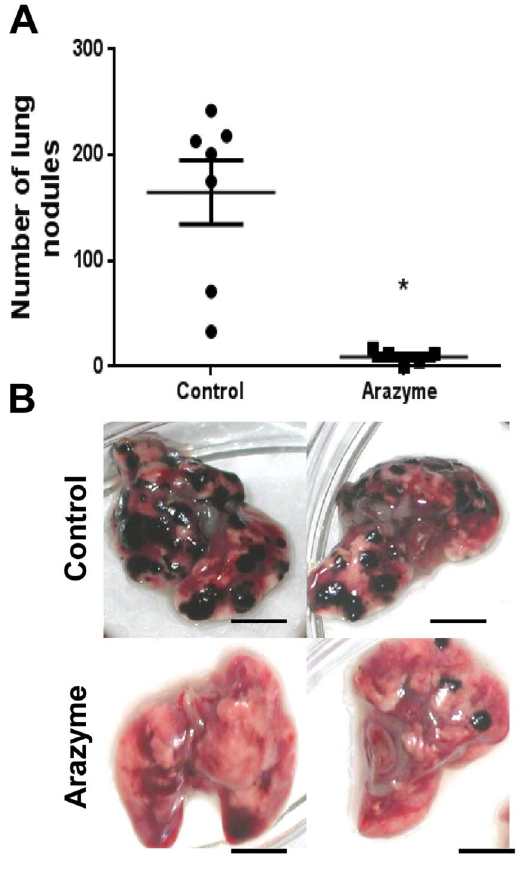
Figure 1. Active arazyme reduces the number of pulmonary metastatic nodules in the murine melanoma model. ( A ) C57Bl/6 mice were i.v. injected with 5 6 10 5 B16F10-Nex2 melanoma cells. Starting on the 1 st day after tumor cell inoculation, active arazyme (3 mg/kg) was administered i.p. every other day for 21 days. Melanotic pulmonary nodules were counted using an inverted microscope on the 22 nd day. Control group (n=7), arazyme treated group (n=5 ) . The average numbers of nodules and standard deviations are shown. ( B ) Representative lung images of untreated and treated animals. One of three independent experiments is represented. Scale bar, 5 mm. * p , 0.05.